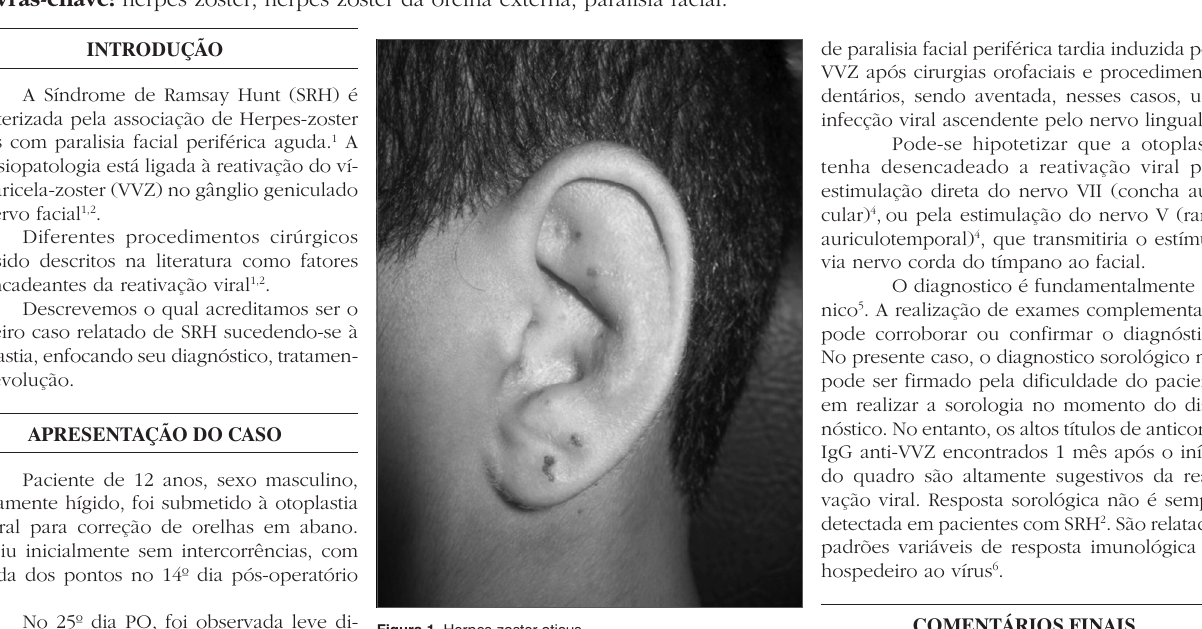
Figura 1. Herpes-zoster